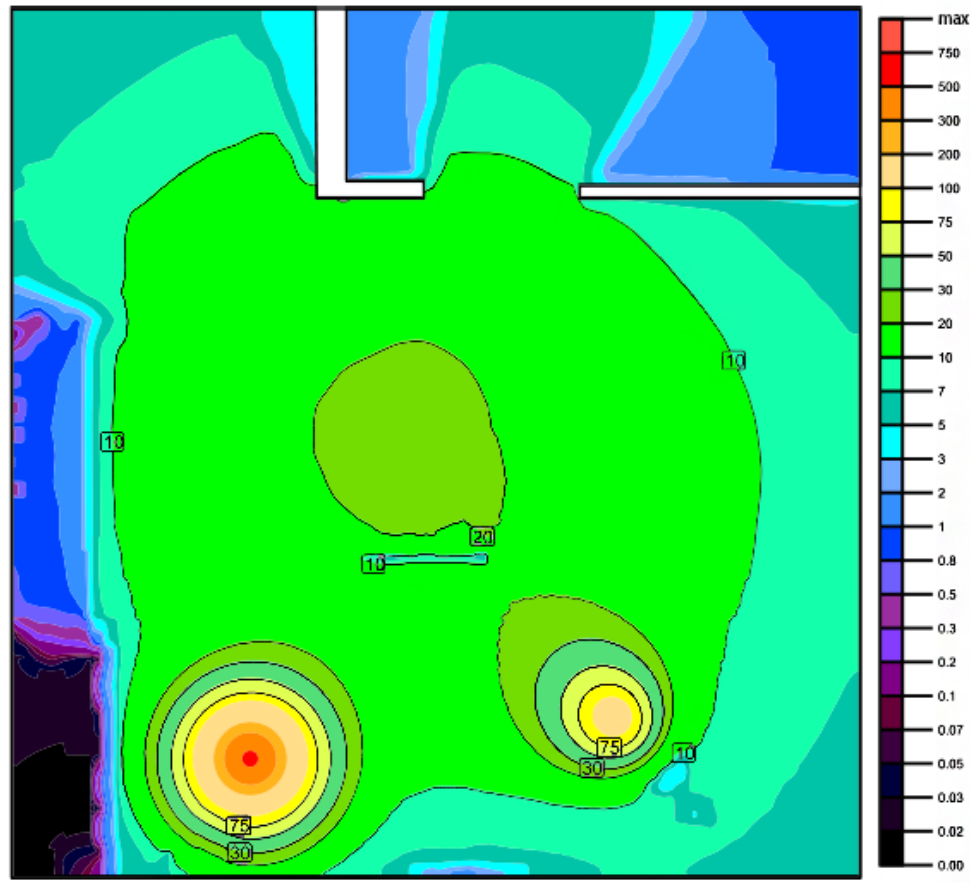
Figure 5. The luminance field map of a bedroom derived from the Radiosity